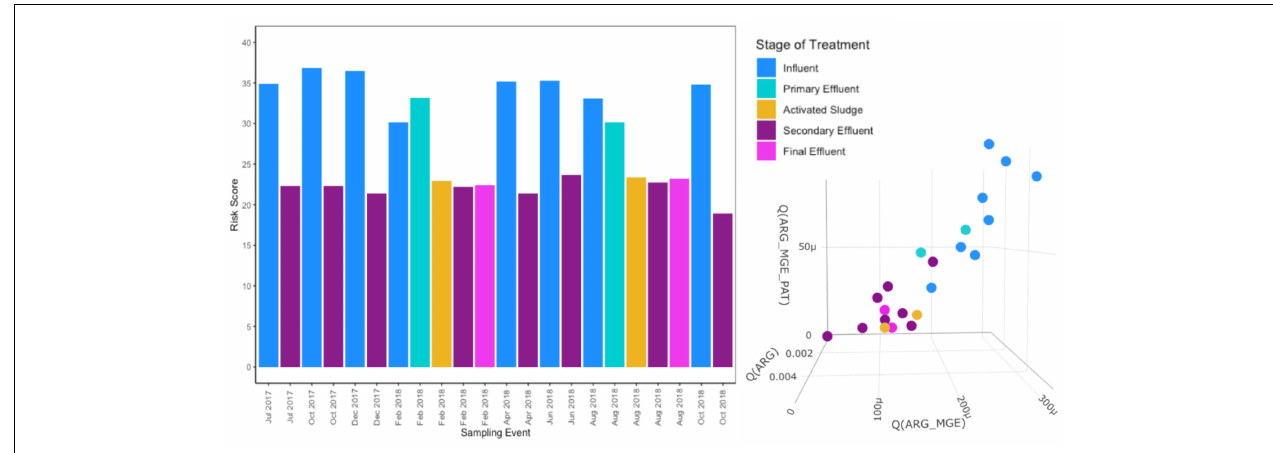
FIGURE 8 | Resistome risk scores and projection in 3D hazard space for each sample as determined by MetaCompare (Oh et al., 2018) using assembled metagenomic data. Risk scores are calculated using: (1) the number of occurrences of ARGs on assembled contigs normalized to the total number of contigs in a given sample, (2) the number of co-occurrences of ARGs and MGEs normalized to the total number of contigs, and (3) the number of co-occurrences of ARGs, MGEs, and human pathogen-like sequences normalized to the total number of